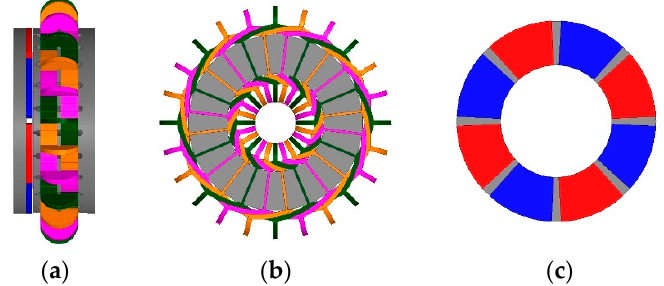
Figure 1. The single gap AFPM machine structure ( a ) total stack; ( b ) the stator with distributed windings; and ( c ) the rotor.